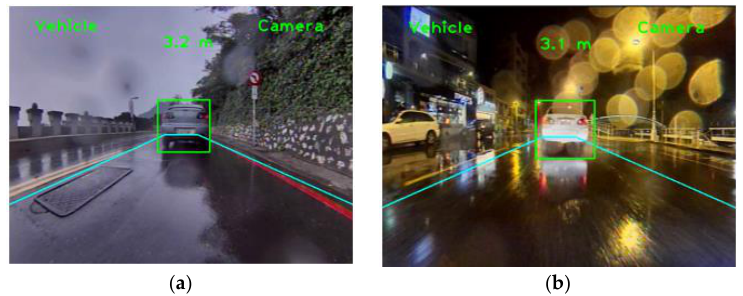
Figure 19. Detection results by vision-based subsystem for a rainy day, ( a ) daytime and ( b ) nighttime.